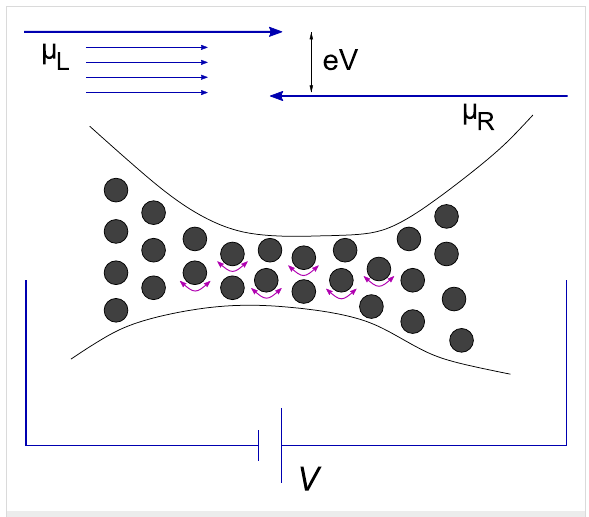
Figure 1: An electrode–junction–electrode system in the Landauer picture. The details are discussed in the